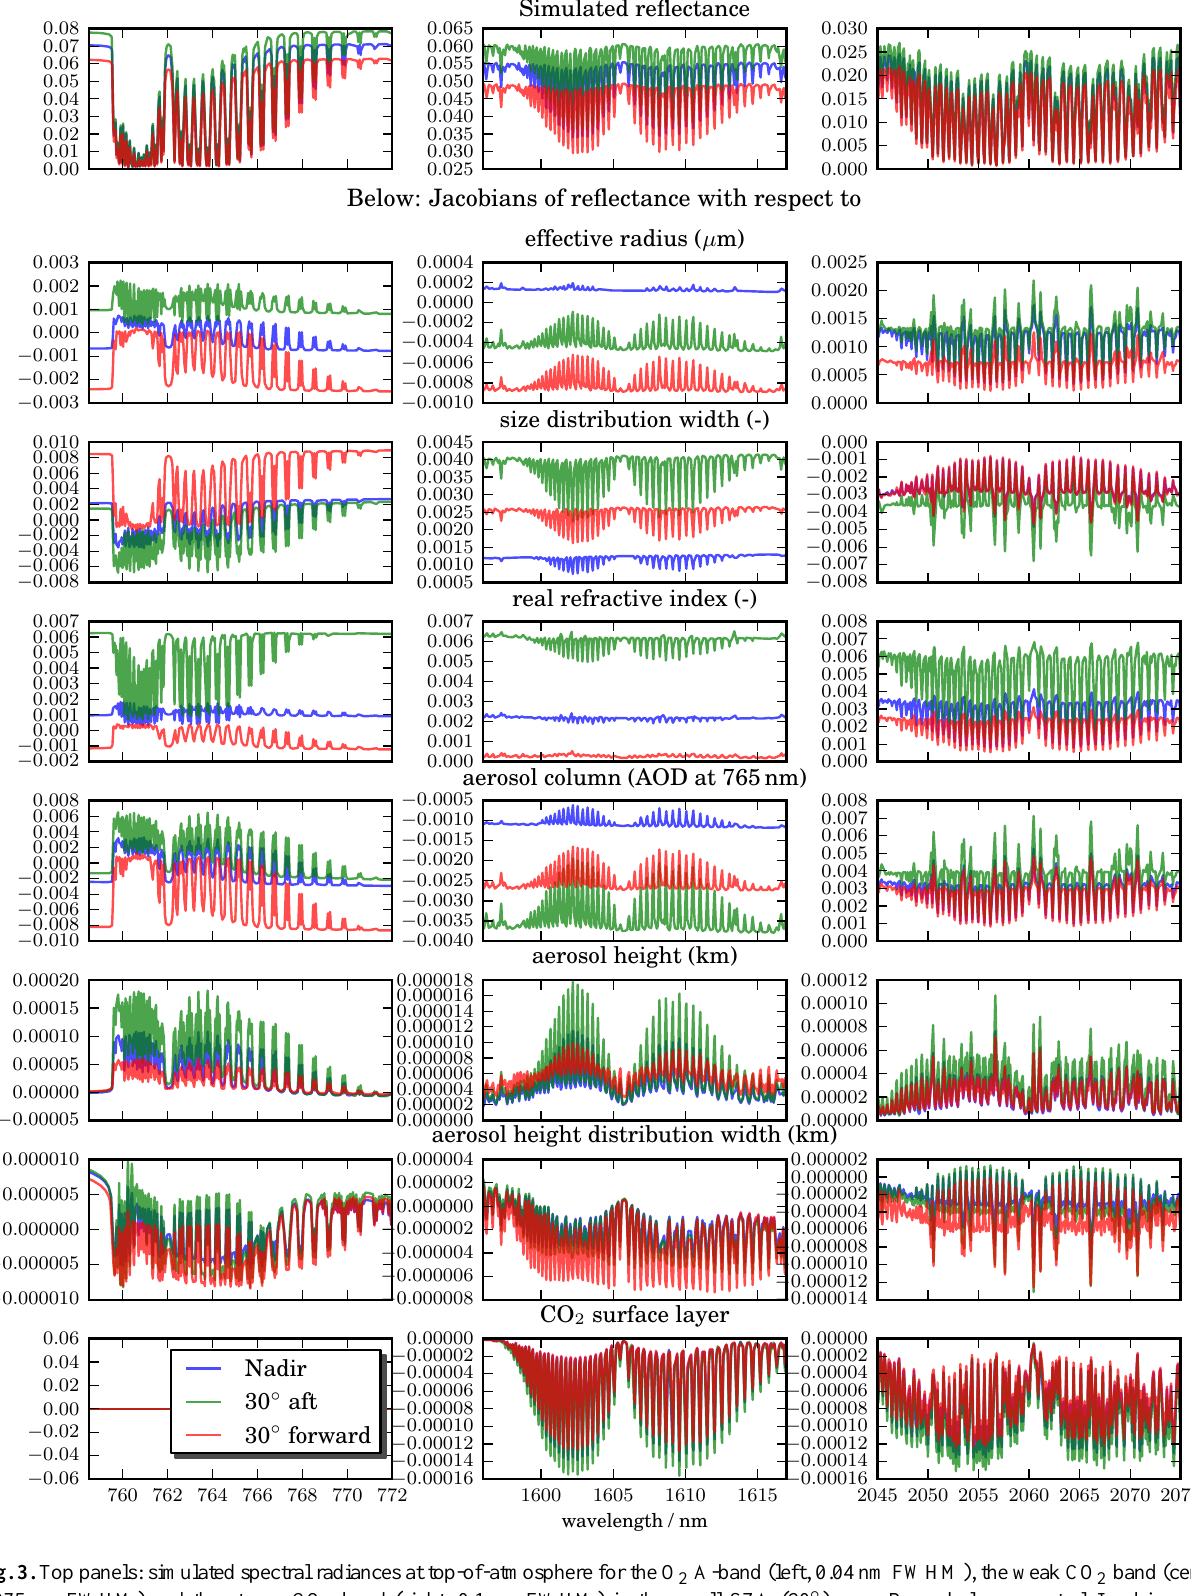
Fig. 3. Top panels: simulated spectral radiances at top-of-atmosphere for the O 2 A-band (left, 0.04nm FWHM), the weak CO 2 band (centre, 0.075nm FWHM) and the strong CO 2 band (right, 0.1nm FWHM) in the small SZA (20 ◦ ) case. Rows below: spectral Jacobians with respect to various aerosol microphysical, amount and vertical distribution properties. Bottom panels: Jacobian with respect to a change in CO 2 concentration near the